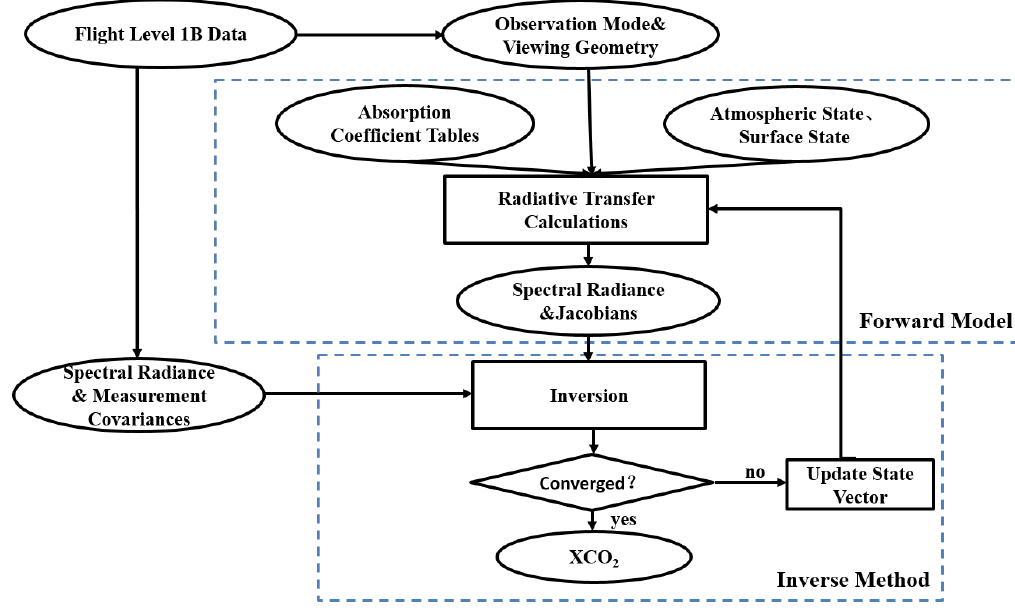
Figure 5. Major components and tasks included in the retrieval algorithm workflow.